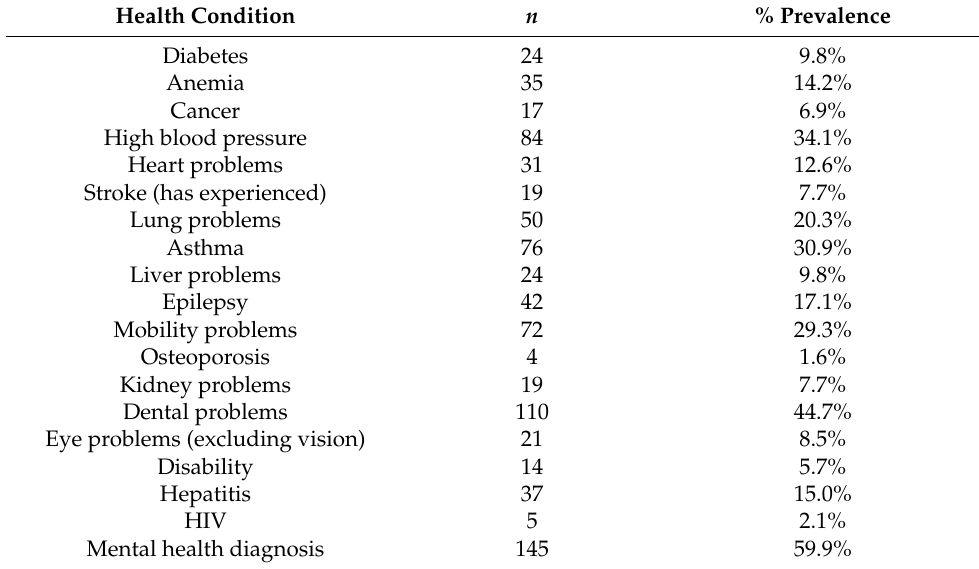
Table 5. Prevalence of self-reported chronic health conditions among n = 246 un-sheltered PEH in Nashville,